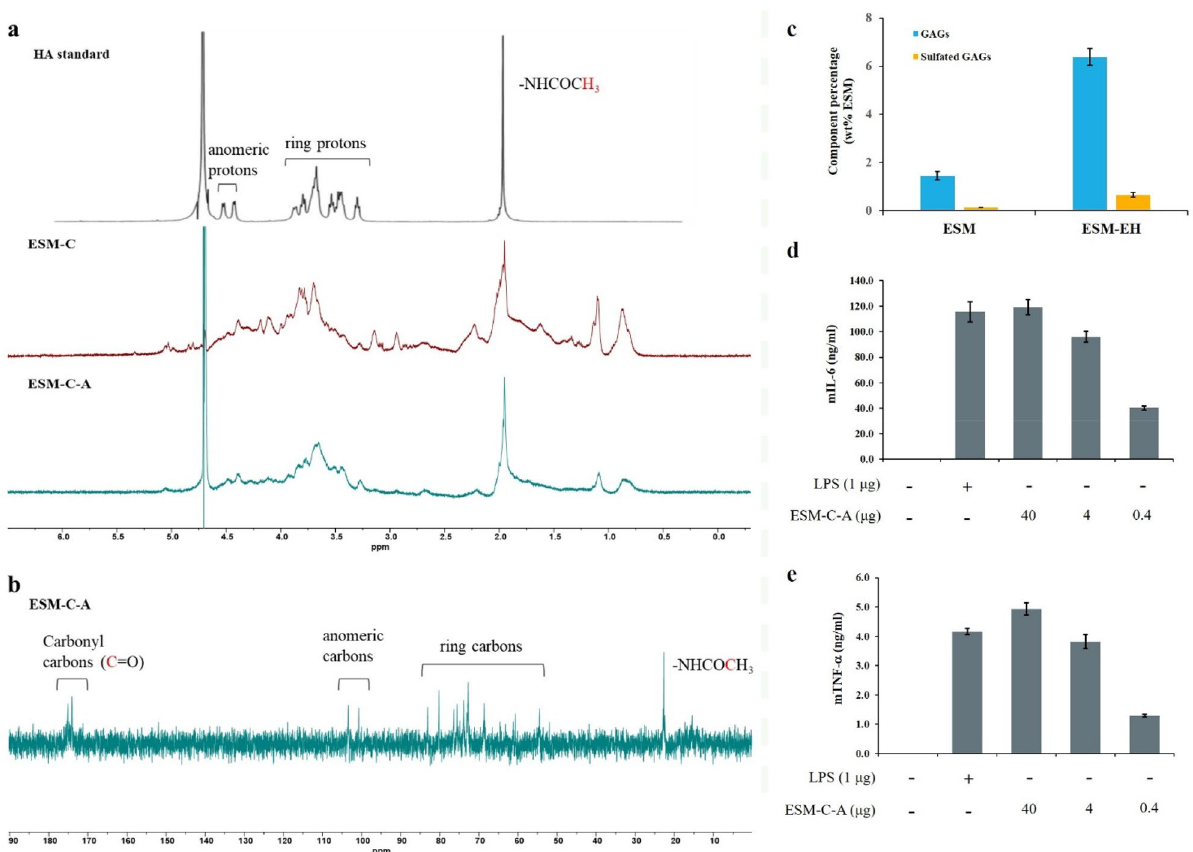
Figure 2. Analysis of ESM enzyme hydrolysate. ( a ) The 1 H NMR spectrum of the HA standard 29 , the crude extract of polysaccharide (ESM-C), and the purified polysaccharides (ESM-C-A). ( b ) The 13 C NMR spectrum of ESM-C-A. Characterization of ESM-C by NMR spectroscopy. The results showed that ESM-C was composed of HA. The spectra data was afforded on MestReNova (ver. 12.0.2) software. ( c ) The ratio of GAGs and sulfated GAGs in ESM enzyme hydrolysate. ESM refers to the control without treating with keratinase and Na 2 SO 3 while ESM-EH refers to ESMP treated with keratinase and Na 2 SO 3 . The production of ( d ) IL-6 and ( e ) TNF-α was detected by the ELISA kit and indicates the immunomodulatory activity of ESM-C-A. Lipopolysaccharide (LPS) was used as a positive control to induce the inflammatory response from mouse J774A.1 macrophages. All the data are displayed as values averaged from at least three independent experiments.